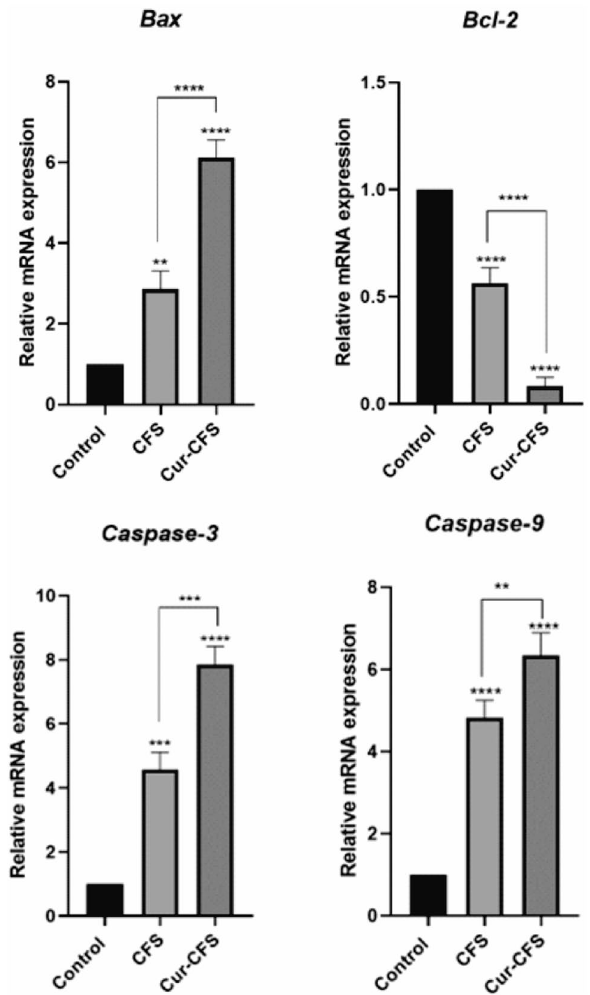
Figure 7. Expression ratios of BAX, Bcl-2, Caspase-9, and Caspase-3 genes in HT-29 colon cancer cells treated with CFS, cur-CFS. The control group was designated as untreated cells (**** p ˂